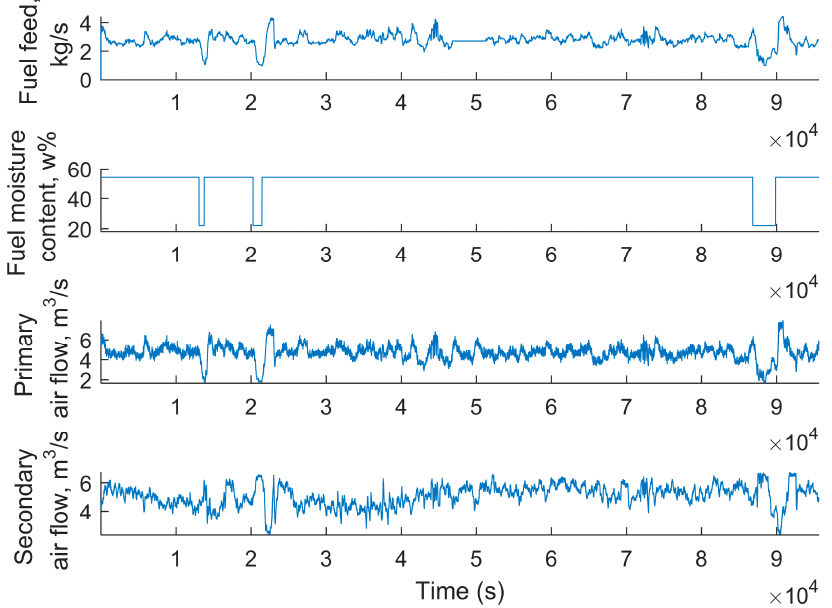
Figure 5. Inputs: fuel feed, fuel moisture, primary air, secondary air.